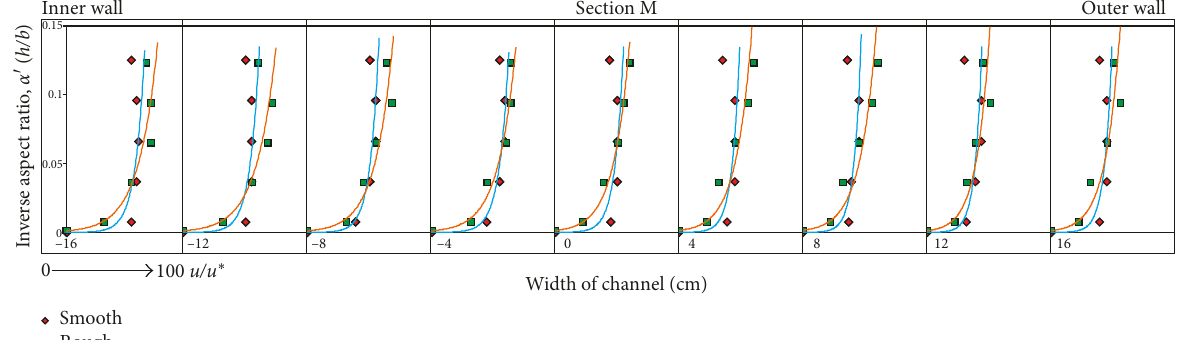
Figure 16: Comparison of velocity variation in section M.